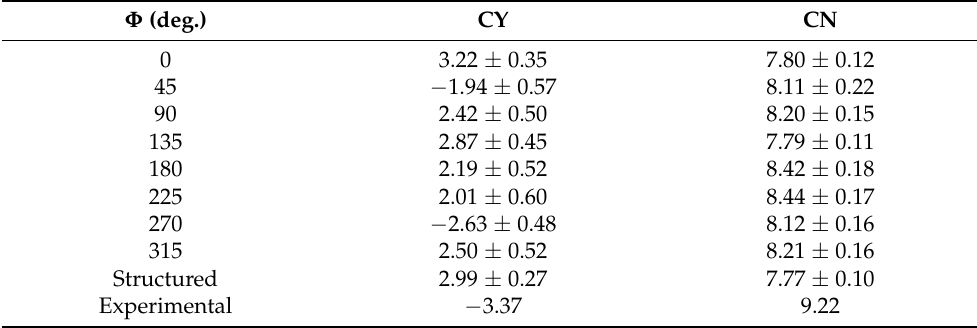
Table 1. Side and normal force coefficients versus roll angle at Ma = 0.2, Re = 2 × 10 6 and α = 45